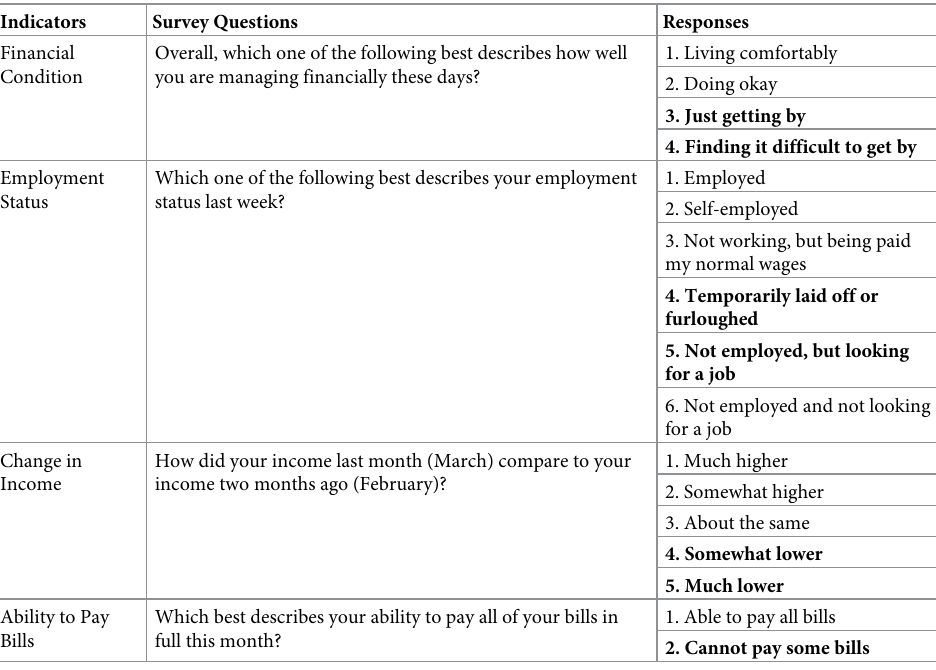
Table 1. Indicators chosen to measure economic